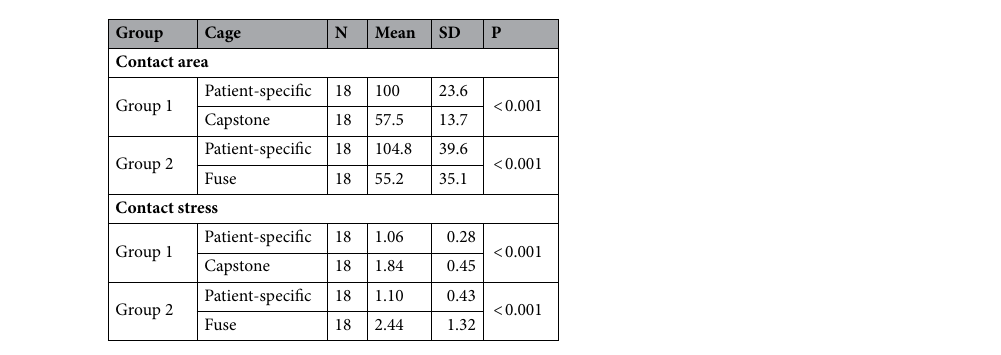
Table 1. Mean ± SD cage contact areas, in mm 2 , and contact stress, in megapascals